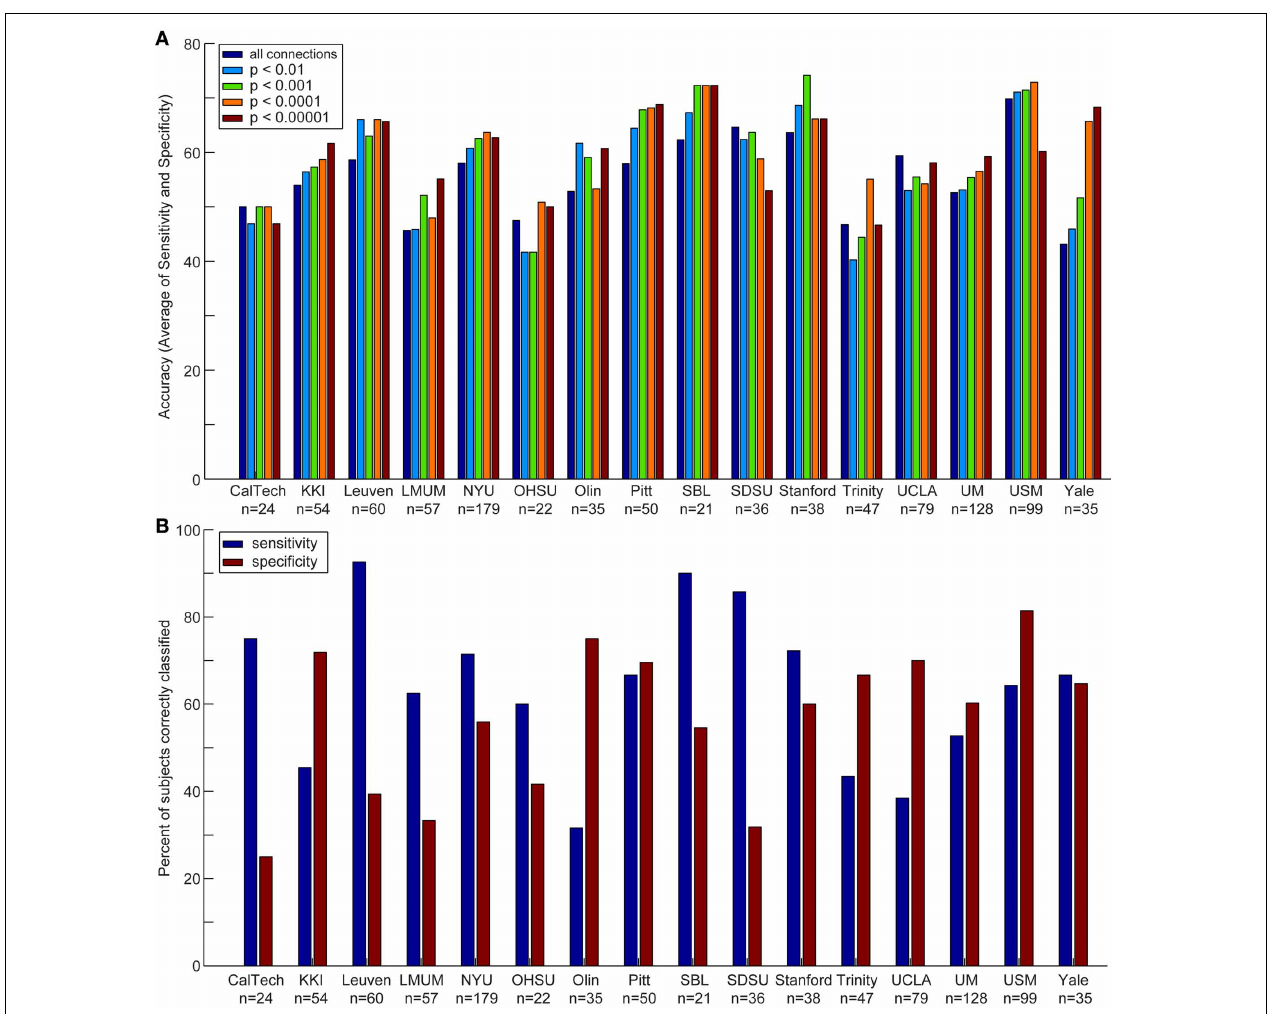
FIGURE 3 | Accuracy, sensitivity, and specificity for each data acquisition site. Accuracy (A) is shown for each data acquisition site at different p -value thresholds. The sensitivity and specificity (B) are